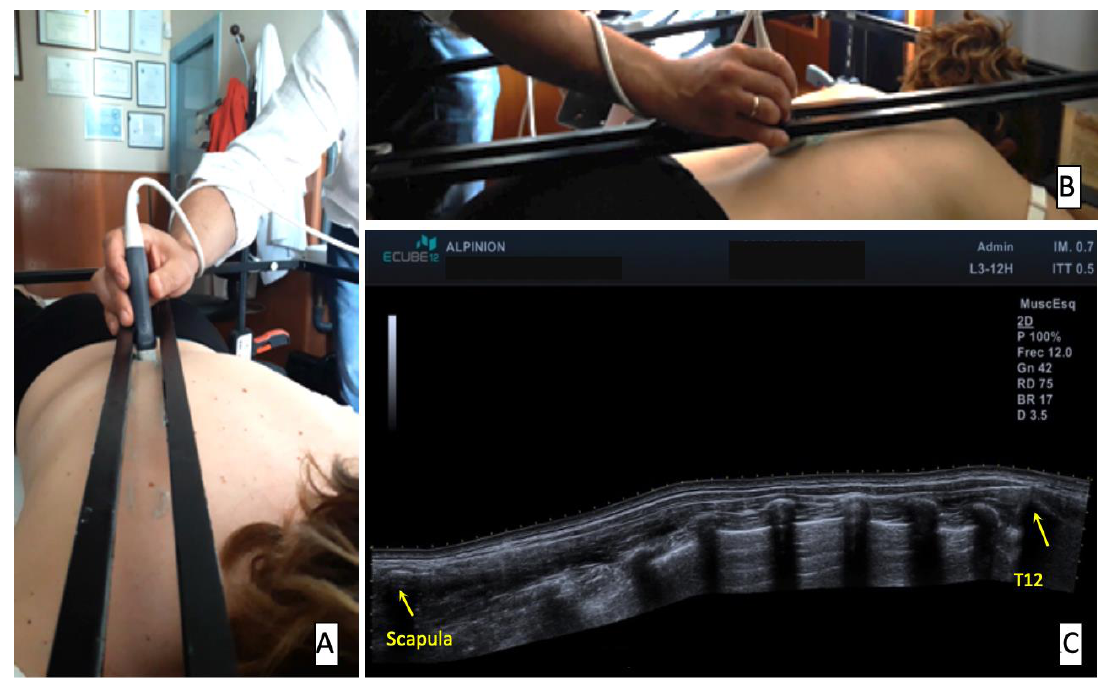
Figure 1. Volunteer setup and panoramic image using SIG_VIP for sampling ( A , B ) and the obtained image ( C ). Yellow arrows refer to the anatomical landmarks of spine of the scapula and spinous process of T12, origin, and insertion of lower fibers of the trapezius muscle and where the calipers were located to measure the length.